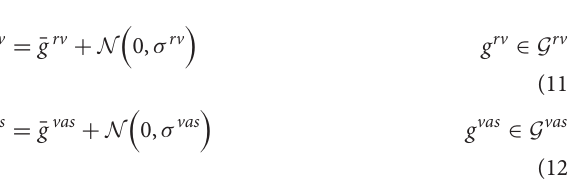
FIGURE 2 | Illustration of how a priori knowledge about the subject, domain knowledge, experimental measurements, and predictions of a physiology-based mathematical model are combined in the EA to identify cardiovascular parameters for a specific